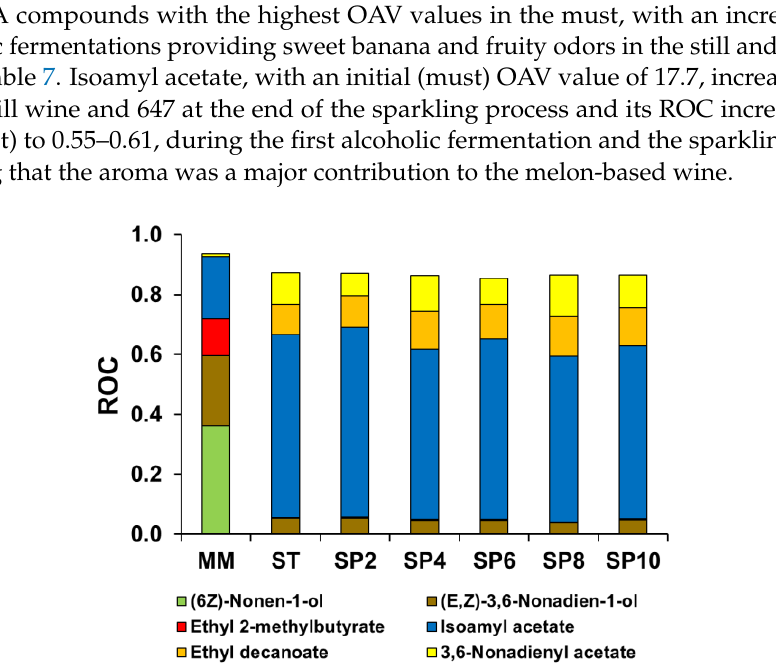
Figure 4. Evolution of principal relative odor contribution value (ROC > 0.1) in enriched must, still wine, and during the sparkling process of melon-based wine (10 weeks). MM: Must. ST: Still wine. SP: Sparkling wine in weeks (2, 4, 6, 8, and 10 weeks).